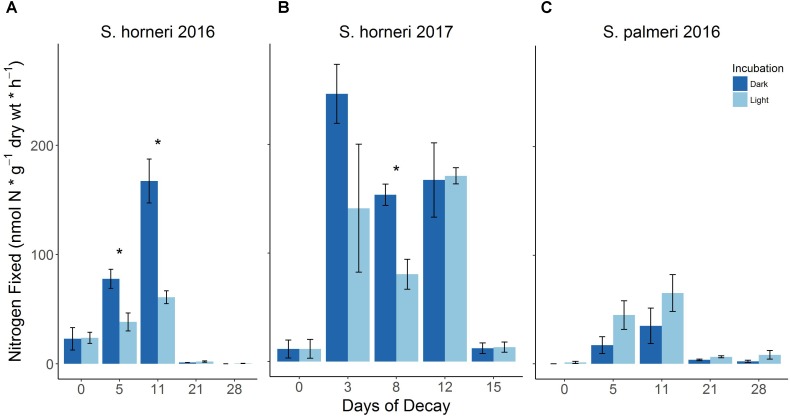
BNF rates associated with decomposing S. horneri
(A,B) and S. palmeri
(C) under dark and light incubations during two summers (2016 and 2017) (error bars represent SE). ∗p < 0.05.